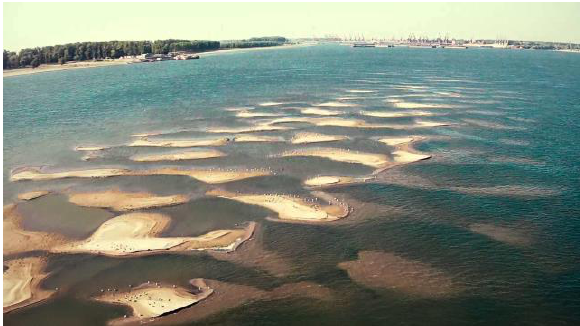
Figure 1. Sand banks emerged in the Danube navigable channel